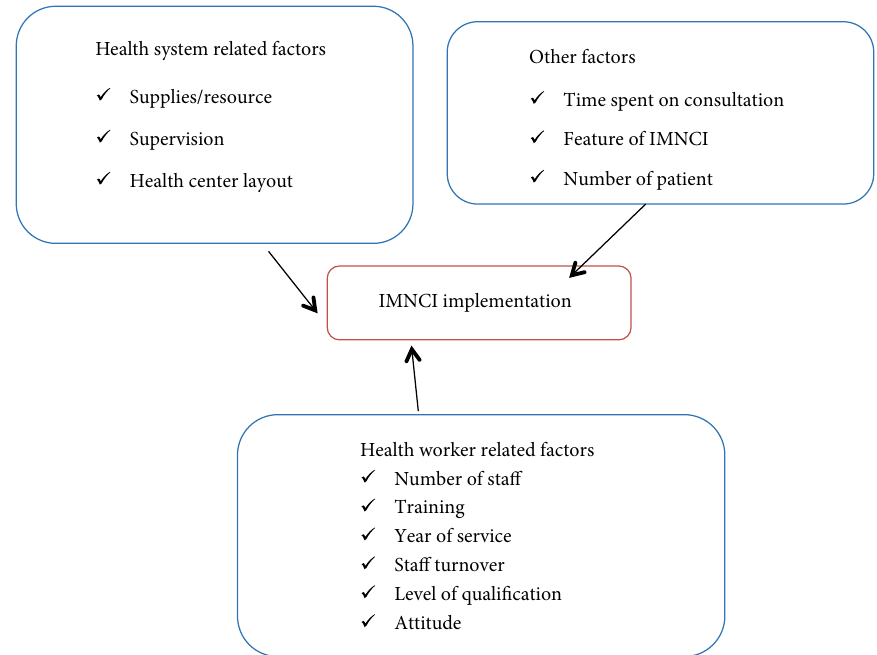
Figure 1: Conceptual framework on factors that influencing IMNCI implementation, adopted by the researchers from Different